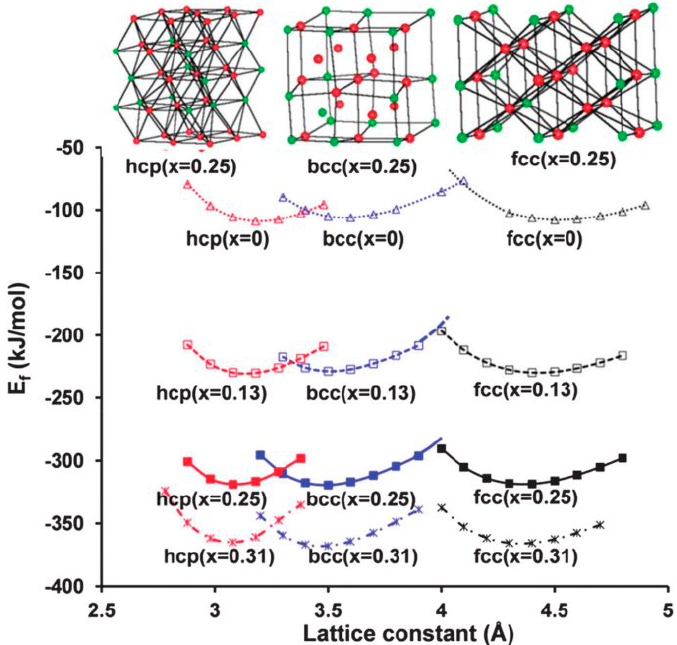
Figure 14. Formation energies of Mg 1 − x Nb x (x = 0, 0.13, 0.25 and 0.31) with various structures as a function of lattice constant. The hcp, bcc and fcc unit cells for Mg 0.75 Nb 0.25 are shown, with Nb atoms being the green spheres. Reprinted with permission from Ref. [102]. Copyright 2012 Royal Society of Chemistry.